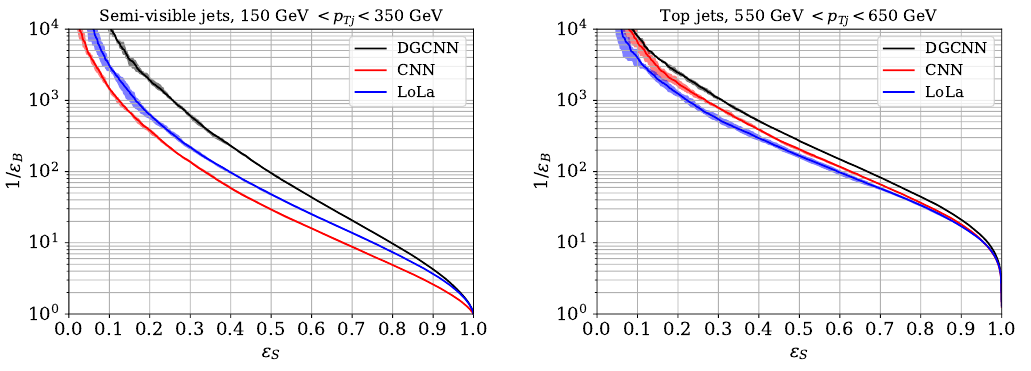
Figure 3: Comparison of the ROC curves in background rejection 1 /ε efficiency ε for semi-visible jet identification (left panel) and for boosted top jet S identification (right panel) as obtained by the CNN, LoLa and DGCNN architectures, respectively. The error bands correspond to the spread obtained from five indepen- dent initialisations of the